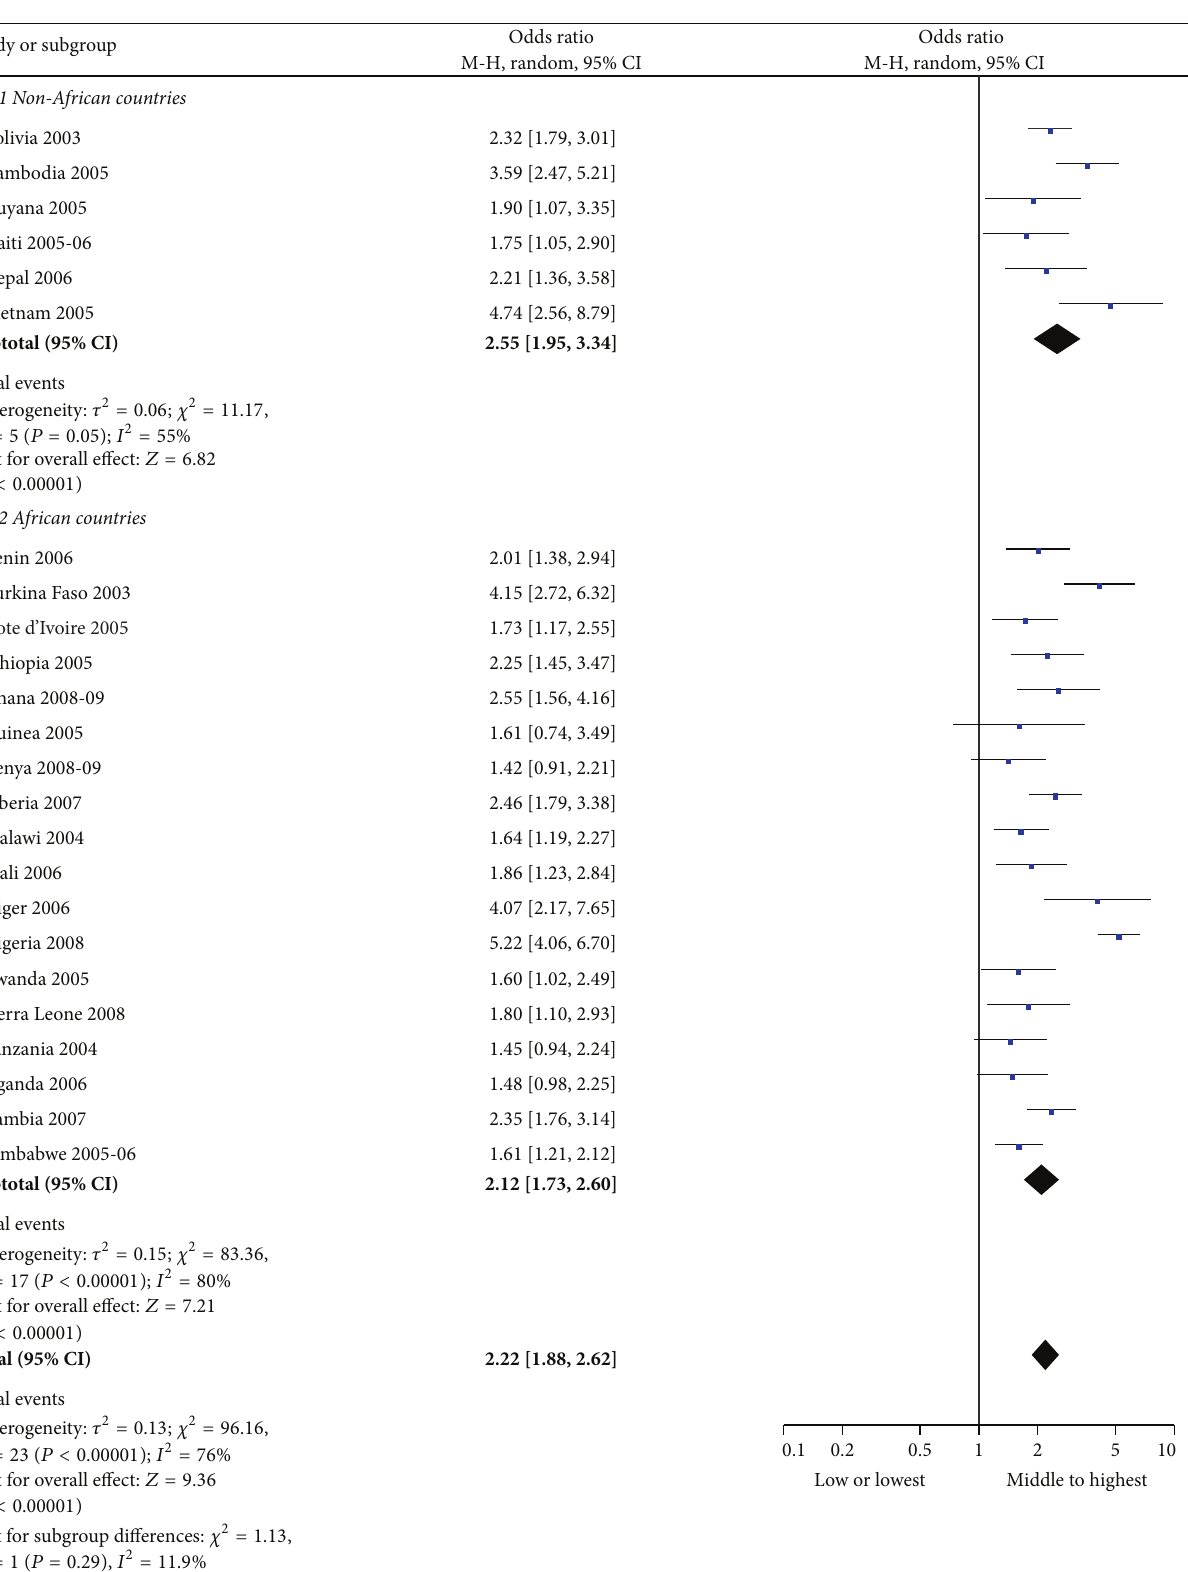
Figure3:Higher-risksexpracticeinprior12monthsbywealthindex(2003–2009).M-H=Mantel-Haenszelstatistic;CI=confidenceinterval. Note: we divided the wealth index into two categories, namely, lowest or low (i.e., the first or second quintile) and middle to highest (i.e., the third through fifth quintiles), to make it fit for the meta-analysis